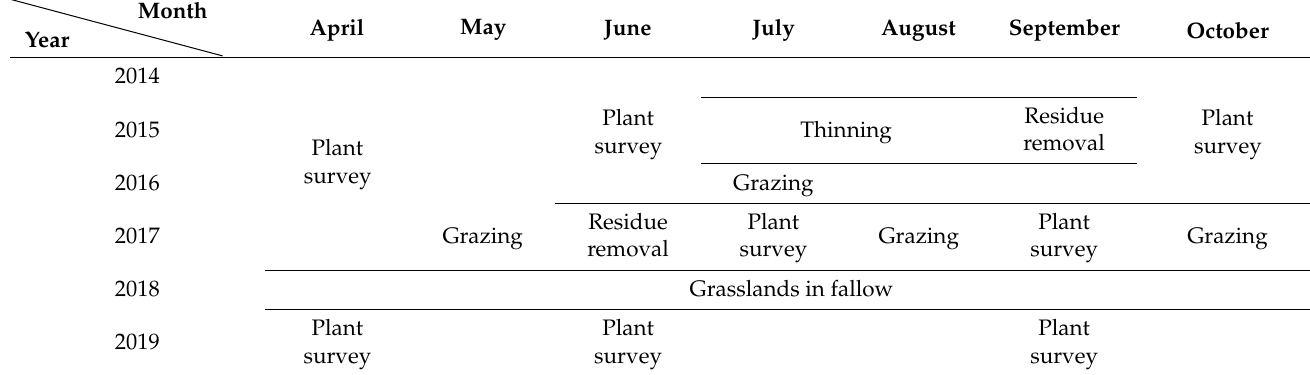
Table 1. Plant survey and disturbances in time courses.